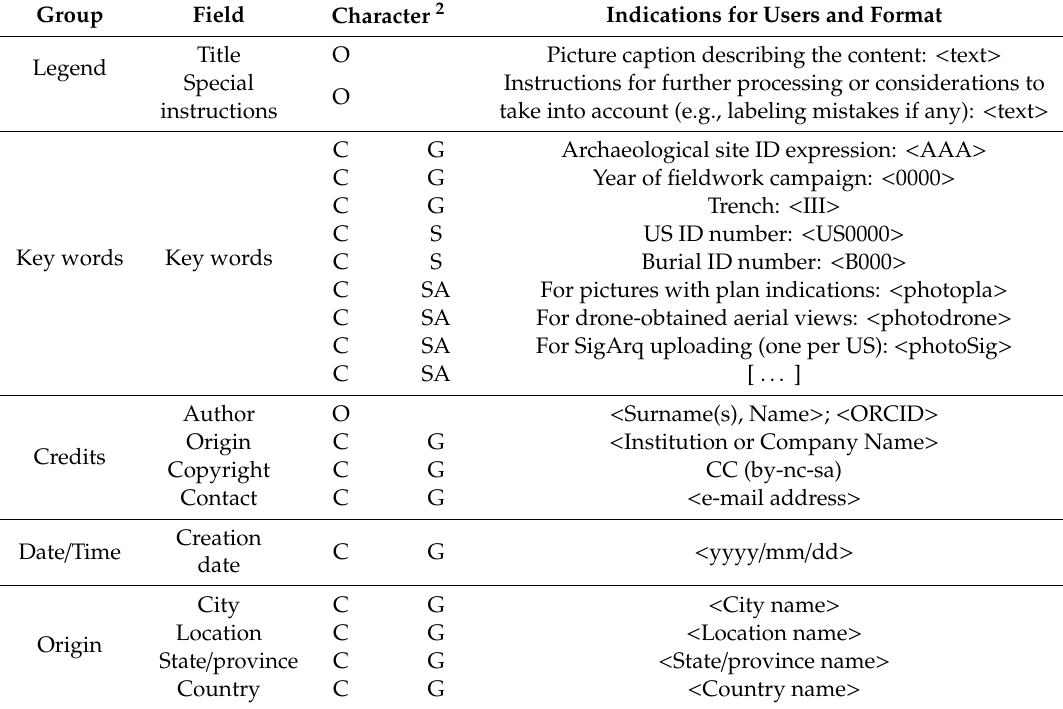
Table 2. File description and secondary assessment through metadata introduction 1 .